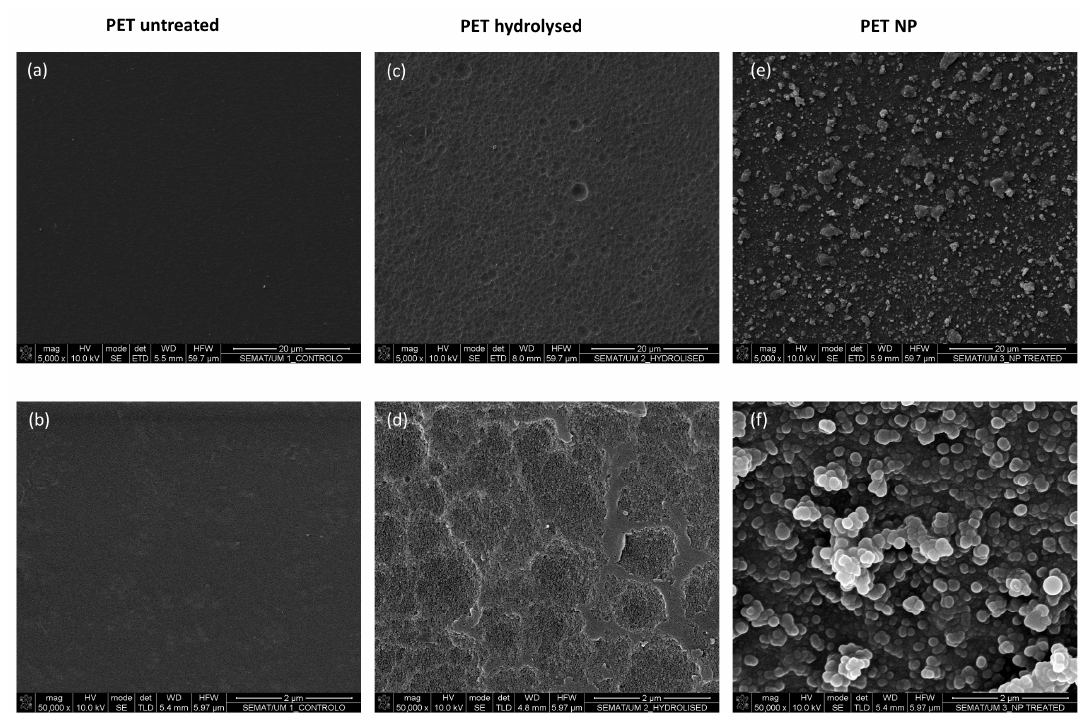
Figure 4. SEM images of untreated ( a , b ), hydrolysed ( c , d ) and NP modified ( e , f ) PET samples, at different magnifications (5000× and 50,000×, respectively).